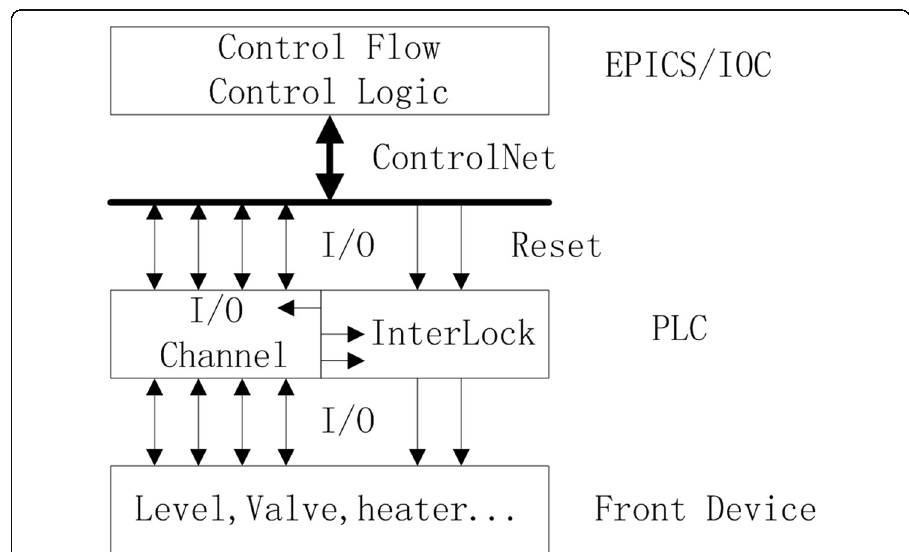
Fig. 8 The superconducting device control of “ EPICS + PLC ” double-layer